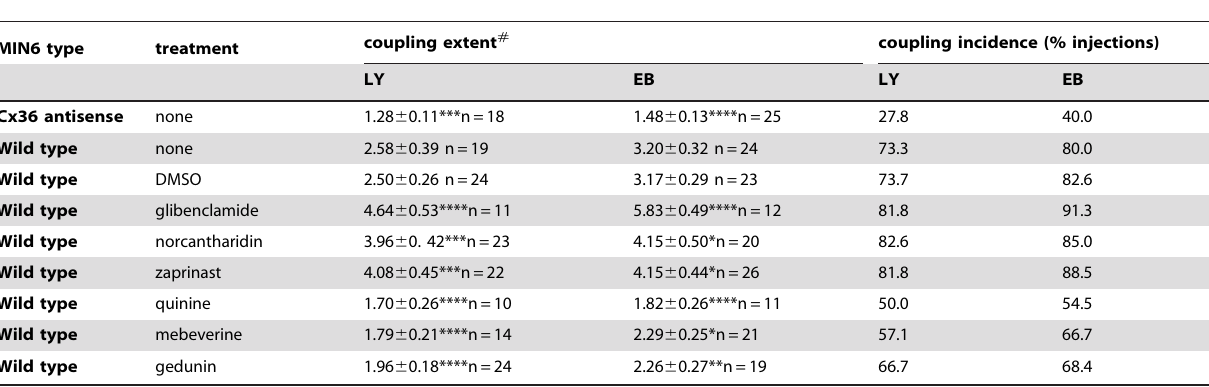
Table 1. Coupling of MIN6 cells, as investigated by tracer